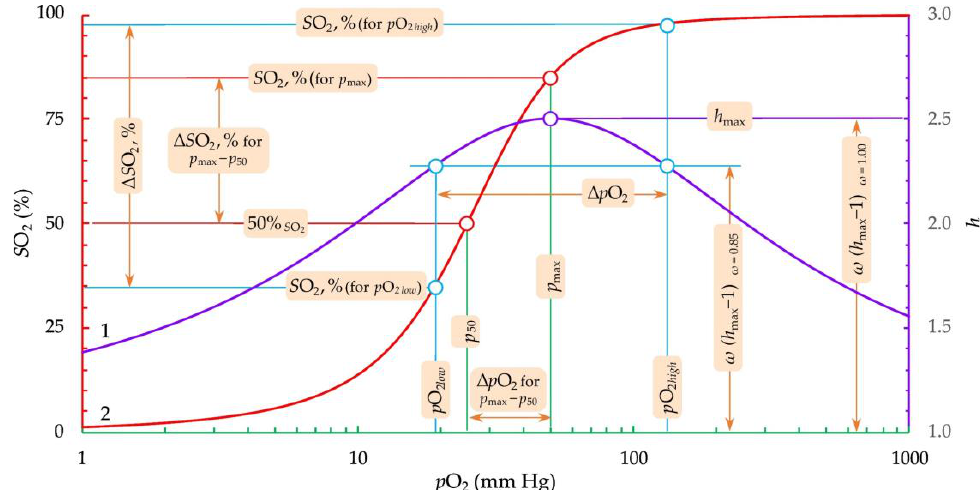
Figure 2. Relation between model fitting parameters and others derived from them, which describe the oxyhemoglobin dissociation curve (ODC). Legend: 1, curve representing Hill’s coefficient dependence with respect to oxygen partial pressure; 2, oxyhemoglobin dissociation curve (ODC); axes: p O 2 , partial pressure of oxygen; S O 2 , oxygen saturation; h , Hill coefficient. The model parameter s in Equation (2) allows obtaining the lowest ( pO 2low ) and high- est ( pO 2high ) values of oxygen partial pressure for h − 1 = ω ( h max − 1), where ω— is the fraction of h max − 1 expressed from 0 to 1 (for ω = 0.5, more commonly known as half-width at half-